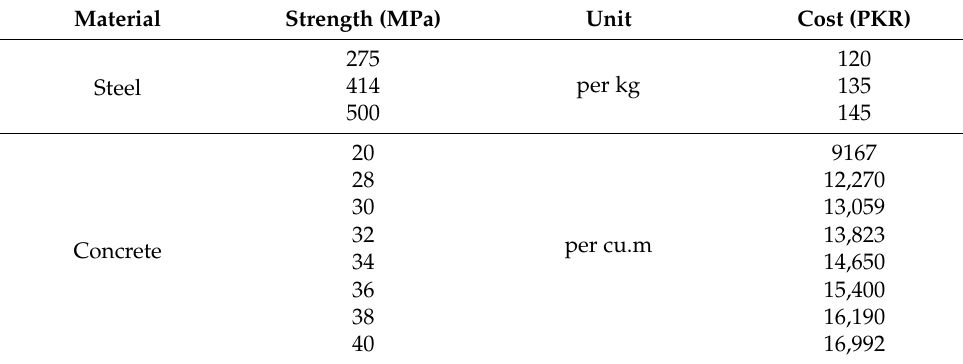
Table 5. The unit costs of the materials used in the parametric